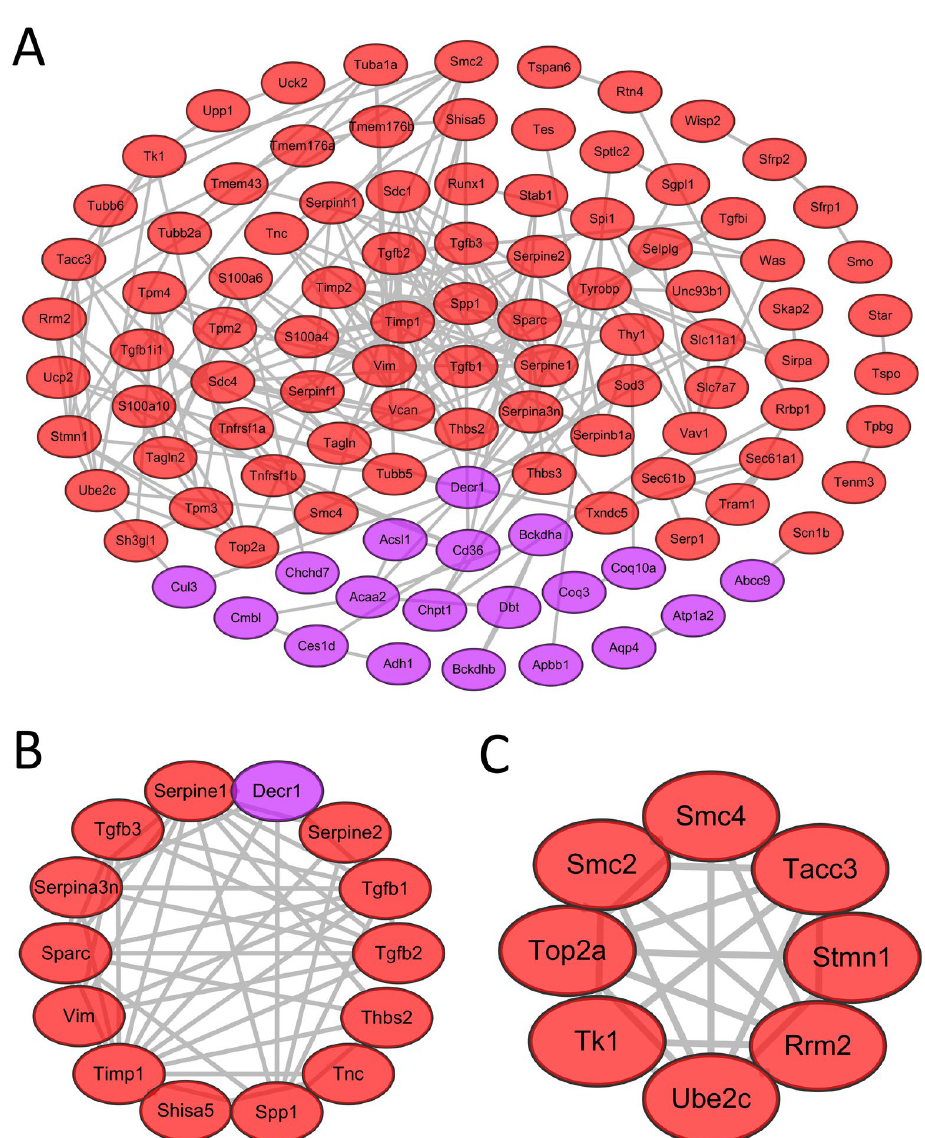
Figure 3. PPI network analysis and module analysis. ( A ) PPI network of uniformly regulated DEGs contains 105 nodes, 239 edges, and 2 modules. ( B ) Network module 1 contains 14 gene nodes and 51 edges (MCODE score = 7.846). ( C ) Network module 2 contains 8 gene nodes and 24 edges (MCODE score = 6.857). Red color represents up-regulated genes and purple represents down-regulated genes. MCODE, molecular complex detection (plug-in of Cytoscape).